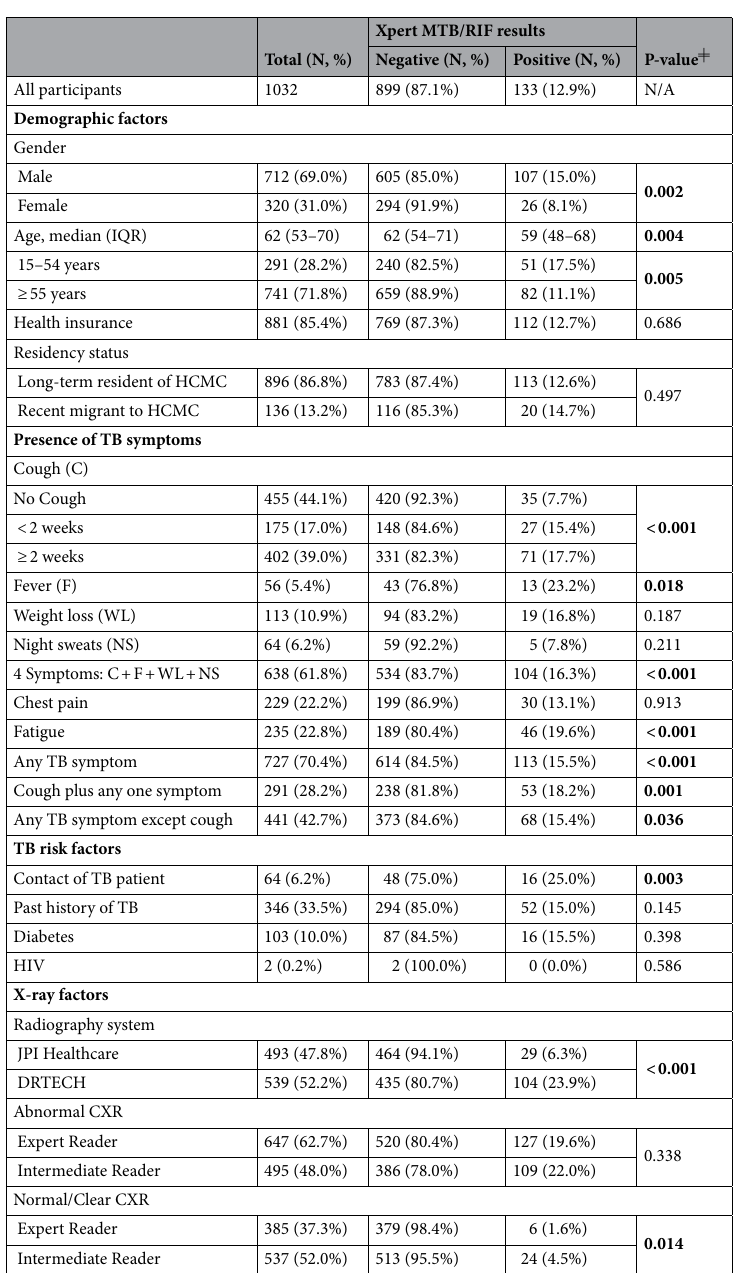
Table 1. Demographic and clinical description of participants included in the test library. Significant values are in bold. ╪ Chi-squared